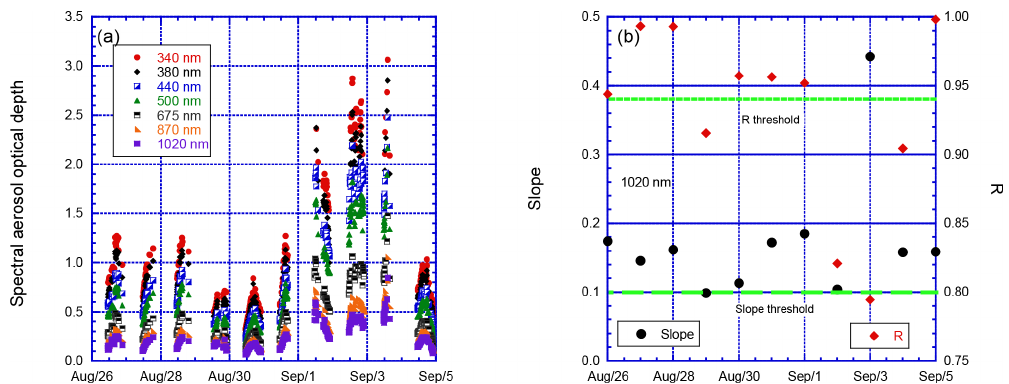
Figure 11. AERONET data collected at Rio Branco (lat − 9.96, long − 67.87) from 15 August to 30 September 2011. (a) The time series of Level 1.5 spectral AOD (cloud screened only) data is plotted from 26 August to 5 September 2011 and shows repeated diurnal dependence for varying magnitudes of AOD. (b) The robust linear fit slope and correlation coefficient ( R ) are calculated from the AOD 1020nm versus the inverse of the optical air mass (m − 1 ). For the full day evaluation, the green dashed line indicates the threshold for the slope parameter at 0.1 and the solid green line indicates the threshold for the correlation coefficient ( R = 0 . 94). Both the slope and R must exceed these thresholds for at least 3 days scanning from the current day to the last occurrence within the 20-day period to remove the spectral AOD, and in this circumstance, all of the data are removed for the period for Levels 1.5 and 2.0.